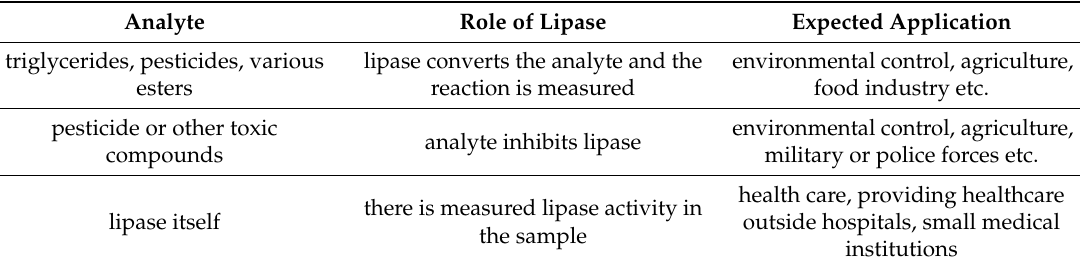
Table 5. The general types of bioassays related to